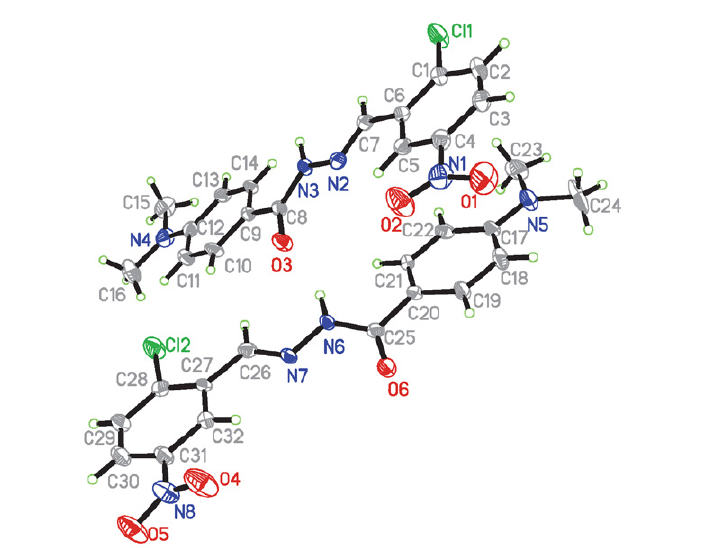
Figure 2. The asymmetric unit of 2 . The ellipsoids are shown with 30% probability.